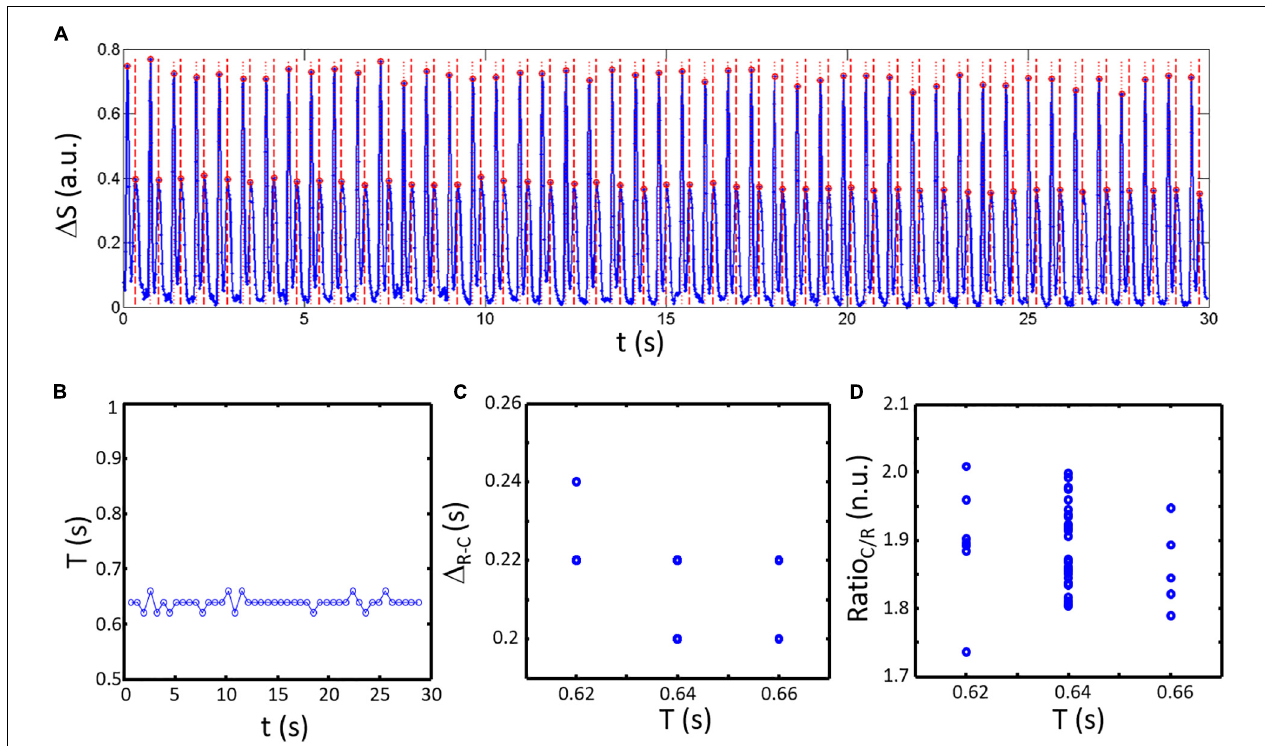
FIGURE 4 | Temporal variation in spontaneous activity obtained by analysis of (cid:49) S with 50 fps. (A) The composite signal obtained for a representative sample (blue line). Detected peaks are highlighted by red circles. Post classification results are shown by dotted red lines (contraction peaks) and dashed red lines (relaxation peaks). (B) The period of activity given the time difference between contraction peaks shows a constant period of activity equal to the pacing cycle length (PCL). (C) Calculated (cid:49) R - C as a function of the period of activity (corresponding here to the time elapse since the last contraction) is only varying by ± one sample. (D) Ratio C / R is more varying compared to (cid:49) R - C .